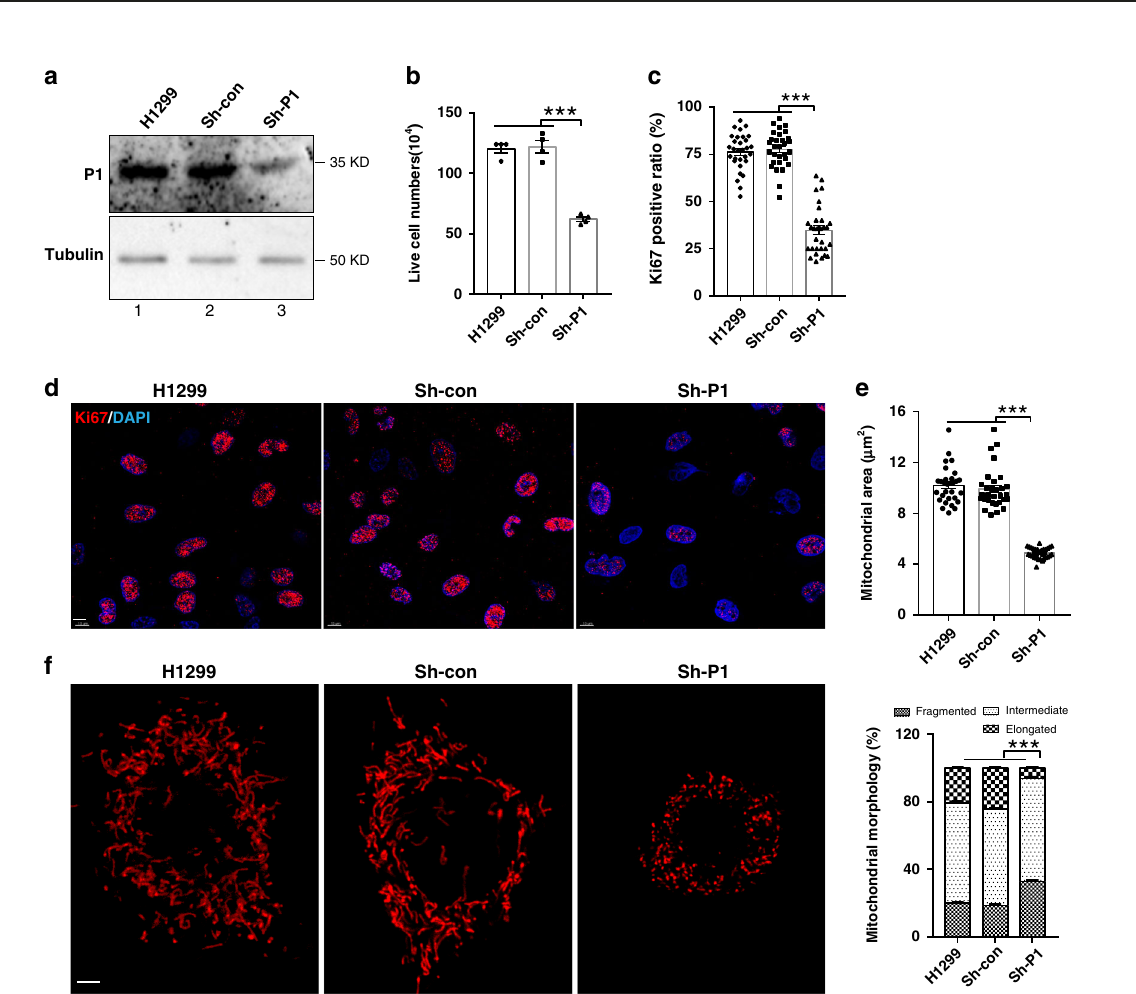
Fig. 2 PINCH-1 regulates mitochondrial fragmentation and A549 cancer cell proliferation. PINCH-1 KO (P1KO) A549 cells were infected with lentiviral vectors encoding 3xFLAG-tagged PINCH-1 (3f-P1), or only 3xFLAG vector (3 f) for 3 days. a Cells (as indicated) were analyzed by Western blotting with antibodies recognizing PINCH-1 (P1) and tubulin. The samples were derived from the same experiment and the blots were processed in parallel. b The numbers of live cells in each well at different time points (as indicated) were analyzed using trypan blue exclusion assay as described in the “ Methods ” ( b , n = 3). c The relative level of mtDNA in the PINCH-1 KO A549 cells was analyzed by RT-PCR as described in the “ Methods ” and compared to that of wild type A549 cells (normalized to 1; n = 5; P = 0.0054). d The cells were stained with DAPI (blue) and antibody for Ki67 (purple). Bar, 25 μ m. The percentages of Ki67-positive cells were quanti fi ed (right, A549 or P1KO + 3f n = 20 fi elds, P1KO or P1KO + 3f-P1 n = 19 fi elds; A549 vs P1KO P < 0.0001, A549 vs P1KO + 3f P < 0.0001, P1KO vs P1 + 3f-P1 P < 0.0001, P1KO + 3f vs P1KO + 3f-P1 P < 0.0001). e , f Mitochondria were stained with MitoTracker Red CMXRos (left panels) and the percentages of mitochondria with different morphologies were quanti fi ed (right panel, A549 n = 80 cells, P1KO n = 30 cells, P1KO + 3f n = 40 cells, P1KO + 3f-P1 n = 39 cells; A549 vs P1KO P < 0.0001, A549 vs P1KO + 3f P < 0.0001, P1KO vs P1 + 3f-P1 P < 0.0001, P1KO + 3f vs P1KO + 3f-P1 P < 0.0001). Bar, 5 μ m. Mitochondrial areas in z-stack images were quanti fi ed ( f , A549 n = 31 cells, P1KO n = 35 cells, P1KO + 3f n = 36 cells, P1KO + 3f-P1 n = 37 cells; A549 vs P1KO P < 0.0001, A549 vs P1KO + 3f P < 0.0001, P1KO vs P1 + 3f-P1 P < 0.0001, P1KO + 3f vs P1KO + 3f-P1 P < 0.0001). g Mitochondria (red arrows) were observed under TEM and the areas of mitochondria were quanti fi ed (right, A549, P1KO or P1KO + 3f-P1 n = 40 mitochondria, P1KO + 3f n = 52 mitochondria; A549 vs P1KO P < 0.0001, A549 vs P1KO + 3f P < 0.0001, P1KO vs P1 + 3f-P1 P < 0.0001, P1KO + 3f vs P1KO + 3f-P1 P < 0.0001). Bar, 500 nm. Data in b – g represent mean ± SEM. Statistical signi fi cance was calculated using one-way ANOVA with Tukey – Kramer post-hoc analysis,** P < 0.01; *** P < 0.001. Source data are provided as a Source Data fi le.